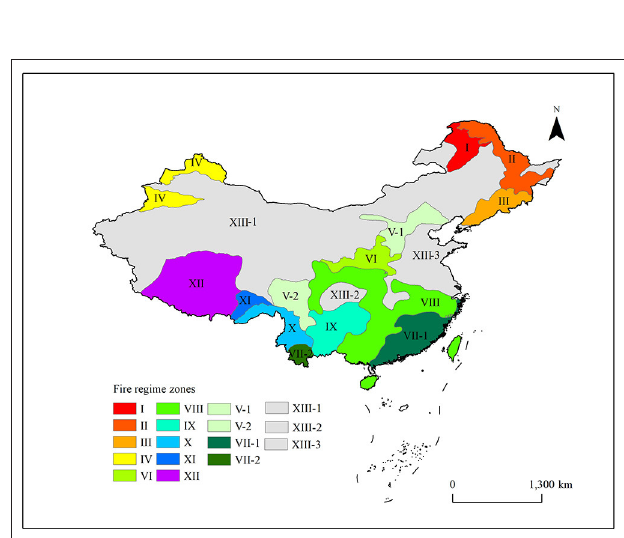
FIGURE 7 | Fire regime zones in China. For detailed information on each FRZ see Table 2